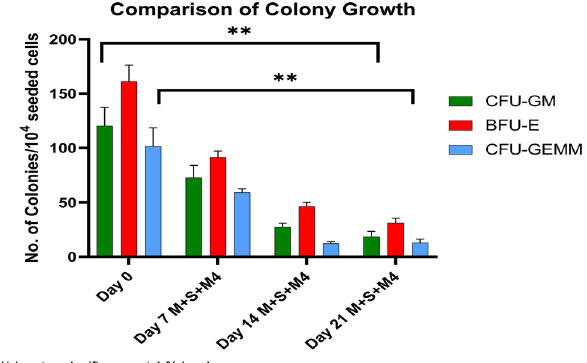
Figure 5. Colony Forming Unit Assay from M + S + M4 vs Day 0. Number of committed progenitors (including CFU-GM, BFU-E, and CFU-Mix) derived from 1 × 10 4 freshly isolated Fetal liver CD34 + HSPCs, denoted as Day 0 vs. colonies generated from invitro expanded cells collected at day 7, day 14 and Day 21 from media combination M + S + M4 (n = 10). Statistical significance among colony forming potential from different media combinations as well as days was analyzed via ANOVA and is depicted with asterisks (*). double (**) asterisks indicate P ≤